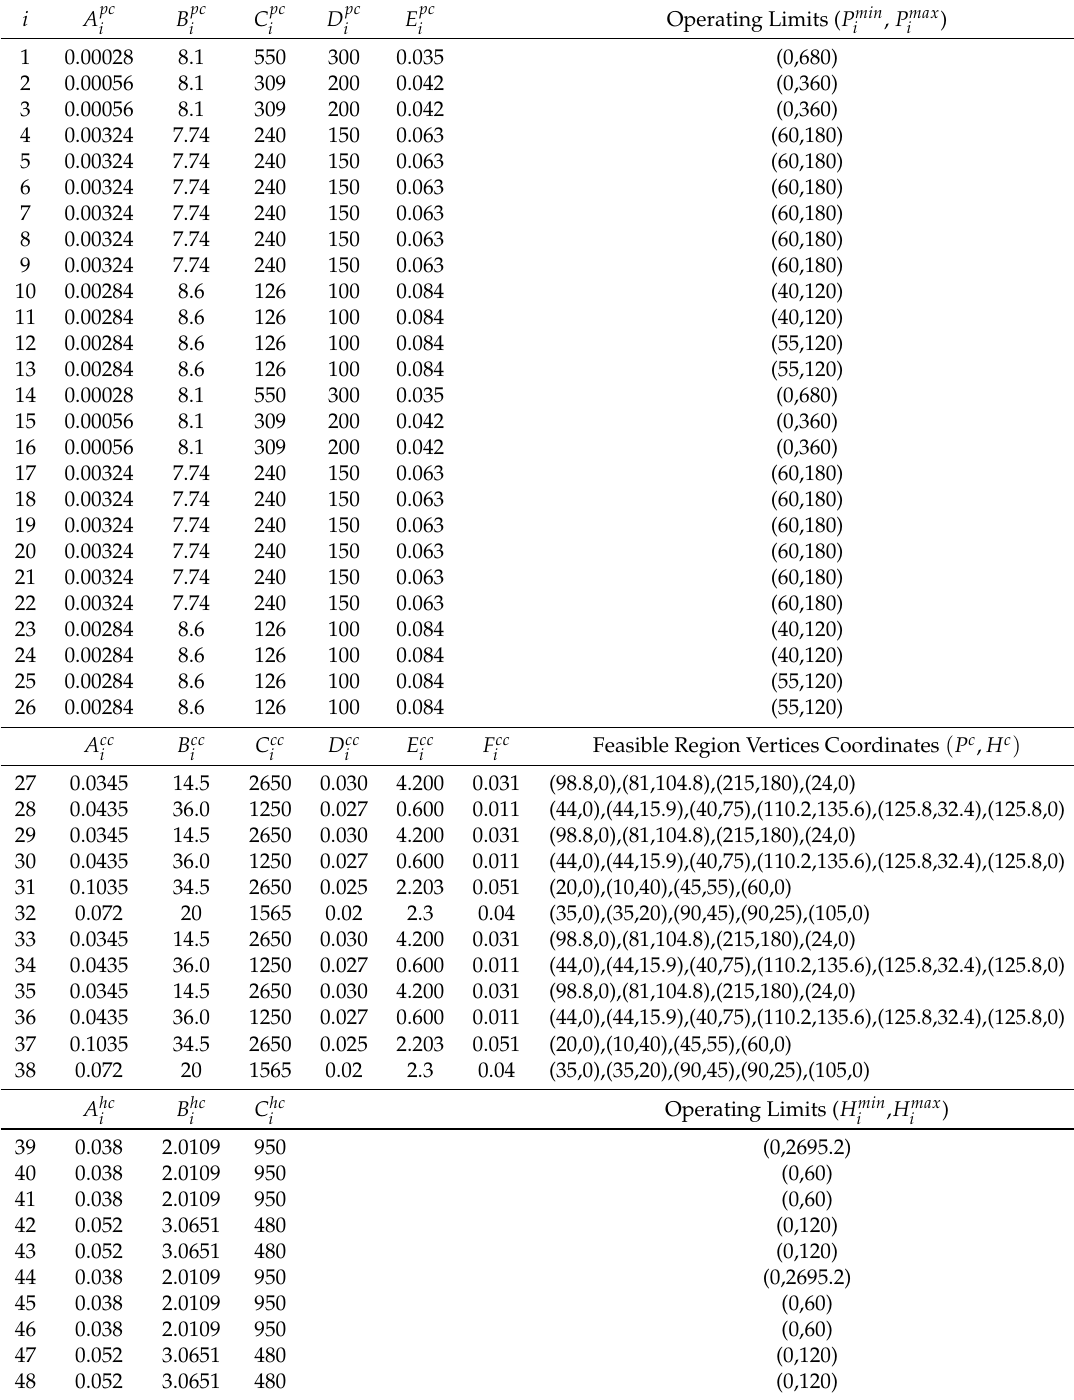
Table A10. Cost functions and operating limits of generating units for test instance